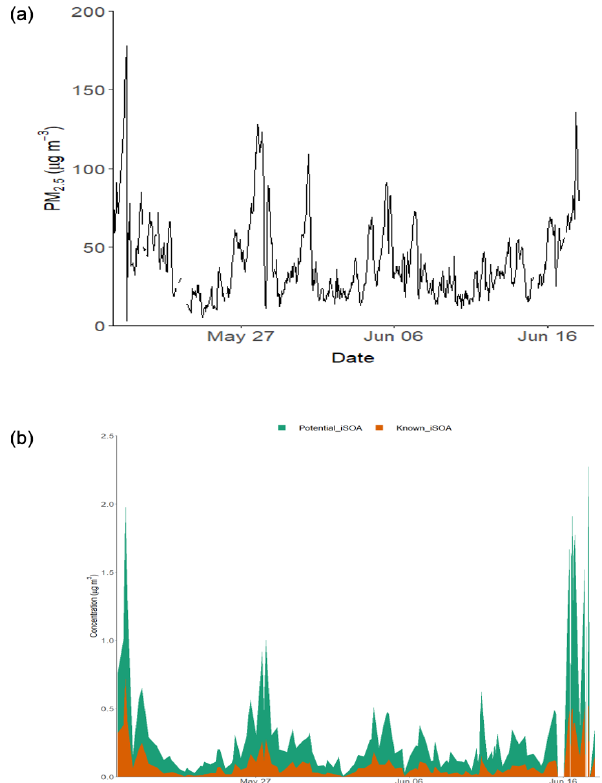
Figure 9. (a) Time series of PM 2 . 5 over the sampling period. (b) Time series of the total known isoprene SOA signal, 2-MT- OS, 2-MG-OS, C 5 H 10 SO 7 (MW 214), C 5 H 8 SO 7 (MW 212), C 5 H 11 NSO 9 (MW 261), C 5 H 9 NSO 10 (MW 275), C 5 H 10 O 11 N 2 S (MW 306) and C 5 H 9 O 13 N 3 S (MW 351); and the total signal from the other iSOA tracers quantified in this